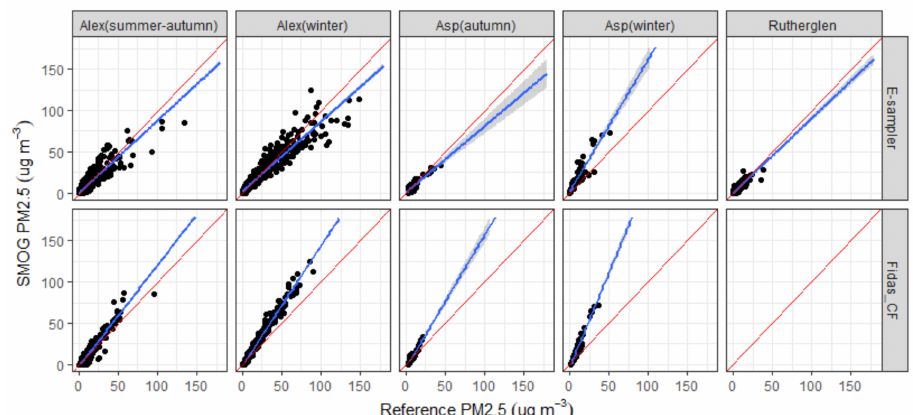
Figure 5. Scatterplot of hourly PM 2.5 concentrations measured with the SMOG units compared to the E-sampler and Fidas_CF (both of which have been corrected against gravimetric mass measurements) by season and location. Blue lines show linear least-squares fit; red line represents 1:1